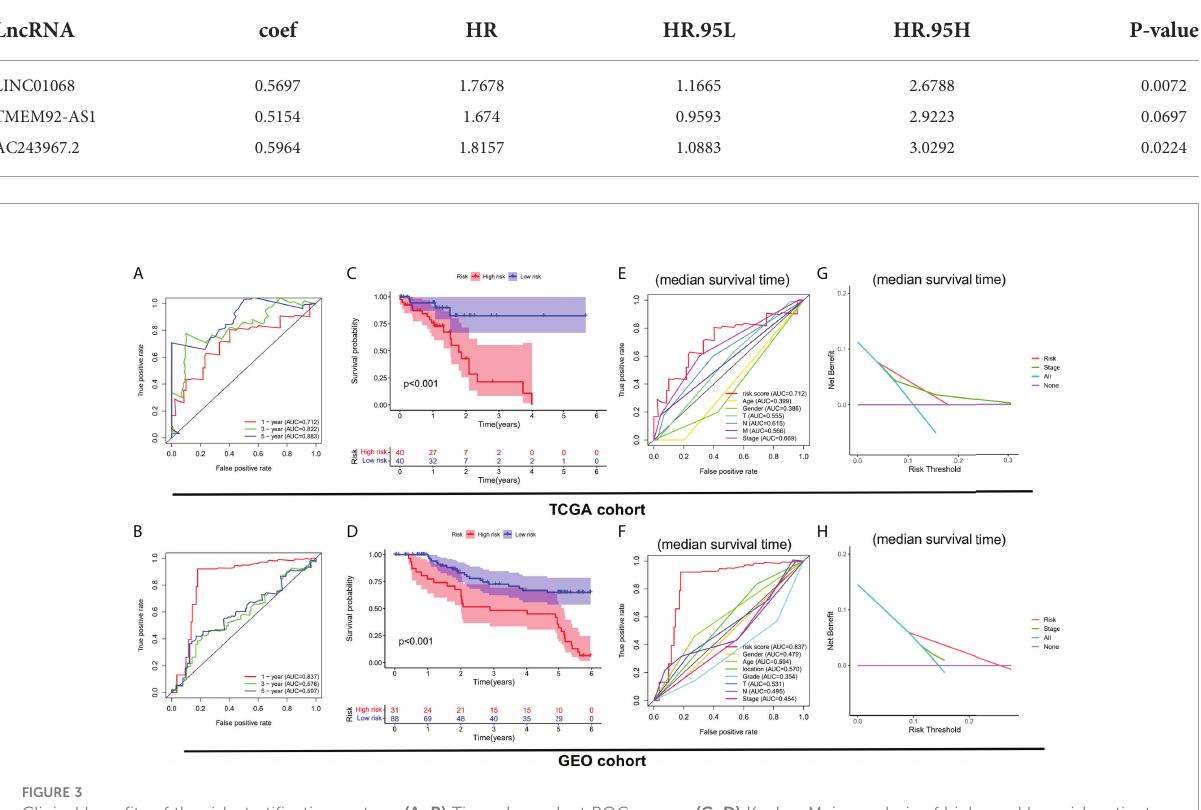
TABLE 1 The optimal prognostic risk strati fi cation system of 3 lncRNAs by multivariate Cox regression